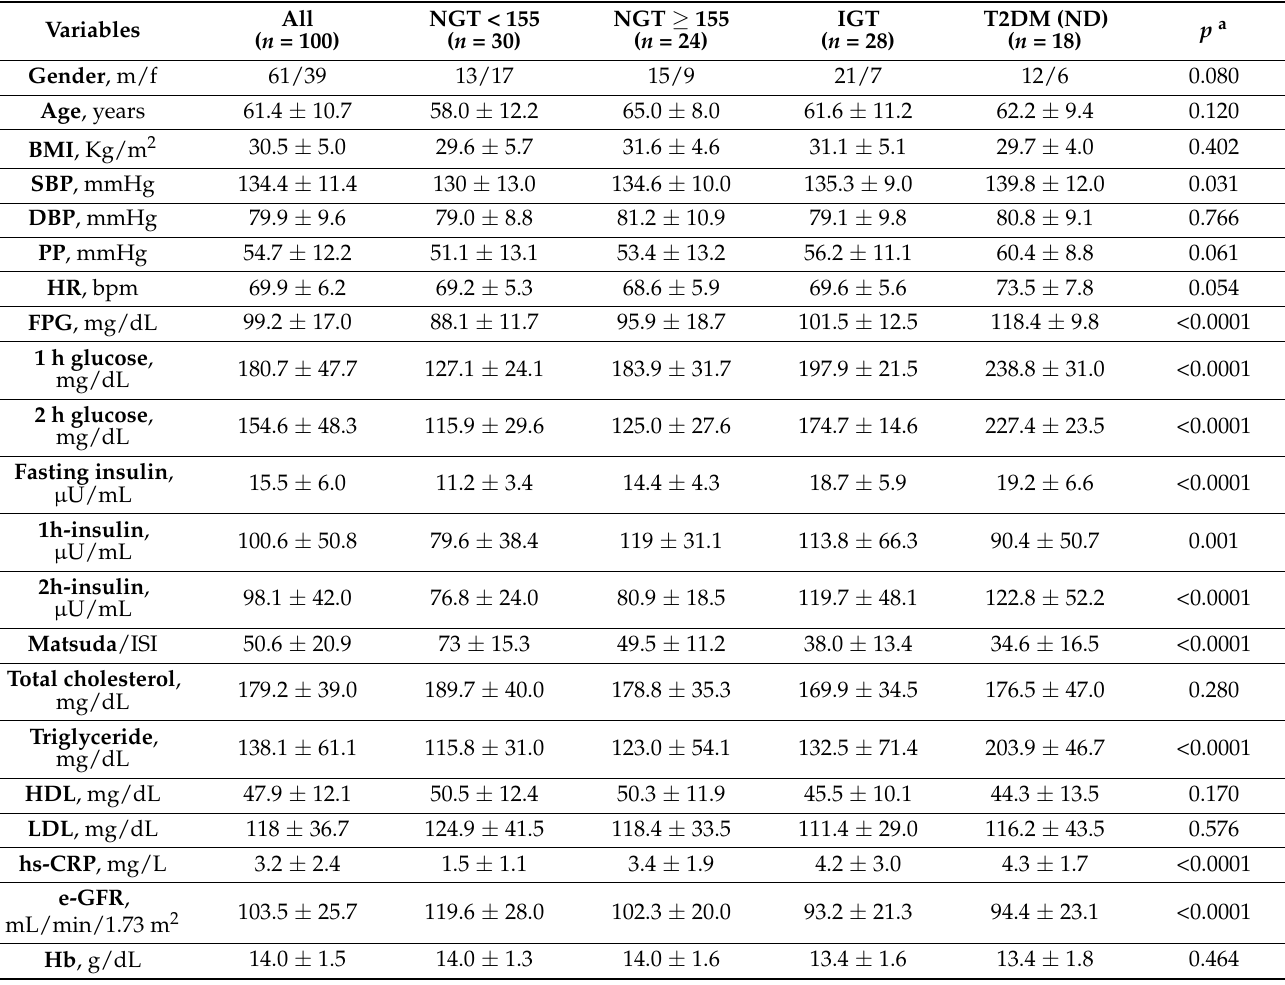
Table 1. Anthropometric, hemodynamic, and biochemical characteristics of the study population according to glucose tolerance